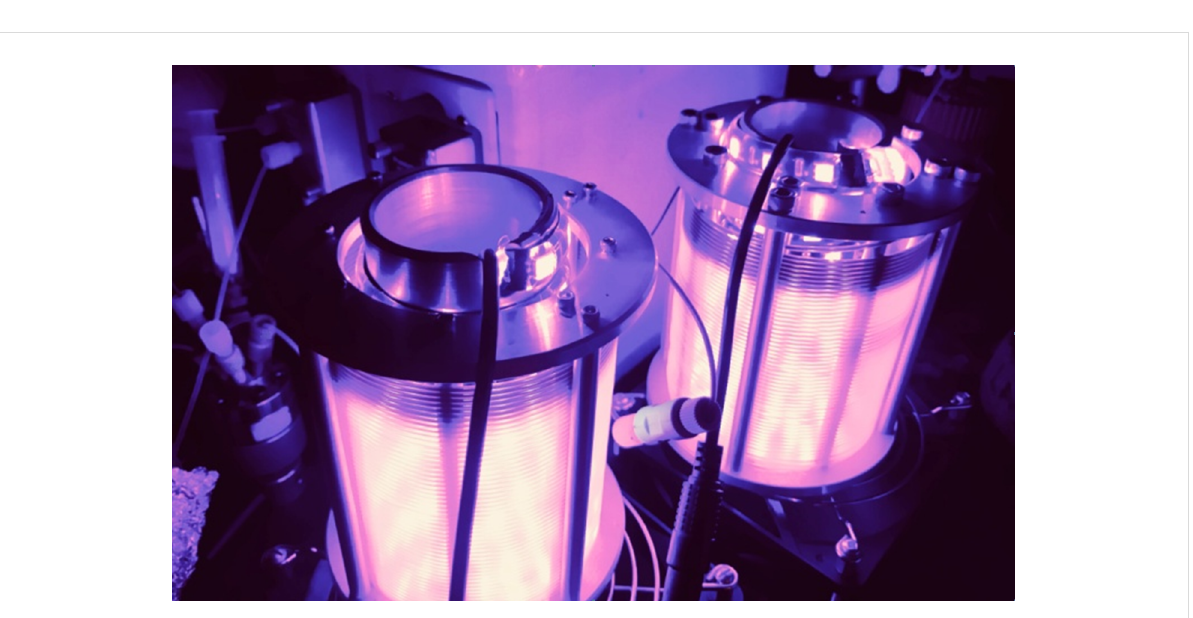
Figure 4: Experimental set-up for the photocatalytic conversion of alcohols to bromides. PFA tubing is wrapped around purple LEDs (394 nm) and fans are placed underneath reactors to maintain